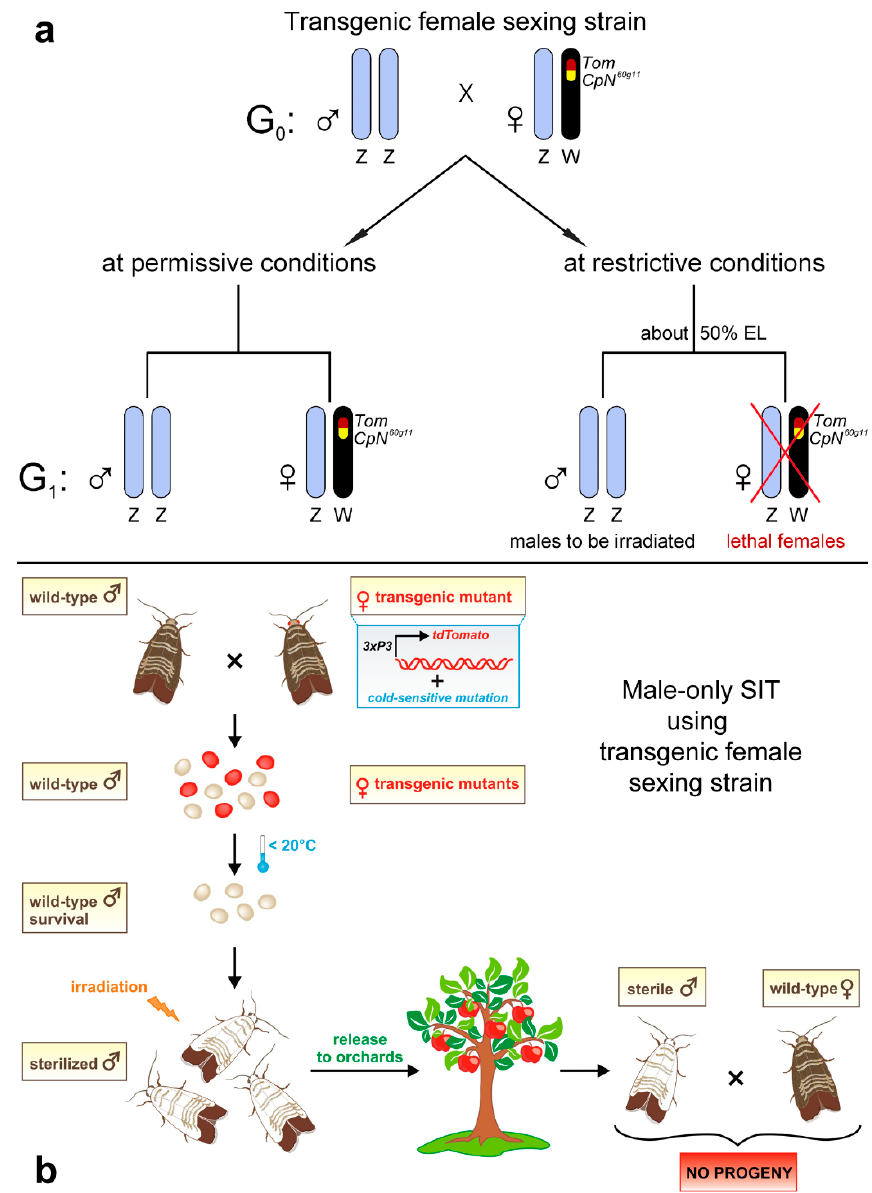
Figure 9. Transgenic female sexing strain proposed for the control of codling moth populations using the sterile insect technique (SIT) [145,153]. ( a ) Scheme of genetic sexing strain based on the use of transgenic females that possess an insert in their W chromosome, containing the tdTomato marker gene (red) and the codling moth ortholog ( CpN 60g11 ; yellow; R. ˇCapkov á Frydrychov á and F. Marec, unpublished) of the dominant cold-sensitive mutant allele of the Notch gene of Drosophila melanogaster , N 60g11 . EL, embryonic lethality. Z and W, sex chromosomes. ( b ) Scheme of male-only SIT using transgenic female sexing strain. Wild-type males are mated with transgenic females, expressing the red fluorescent protein in their eyes under the 3xP3 promoter. The obtained egg collections are exposed to a temperature below 20 ◦ C, resulting in the death of all transgenic female embryos. Non-transgenic male-only o ff spring are kept until adulthood, sterilized by ionizing radiation, and released to apple